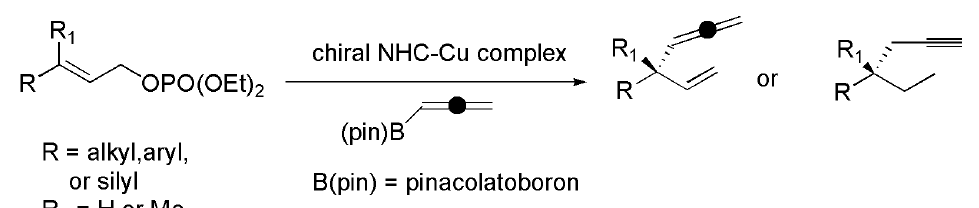
Figure 14. Different reactivity of organometallic reagents [102].